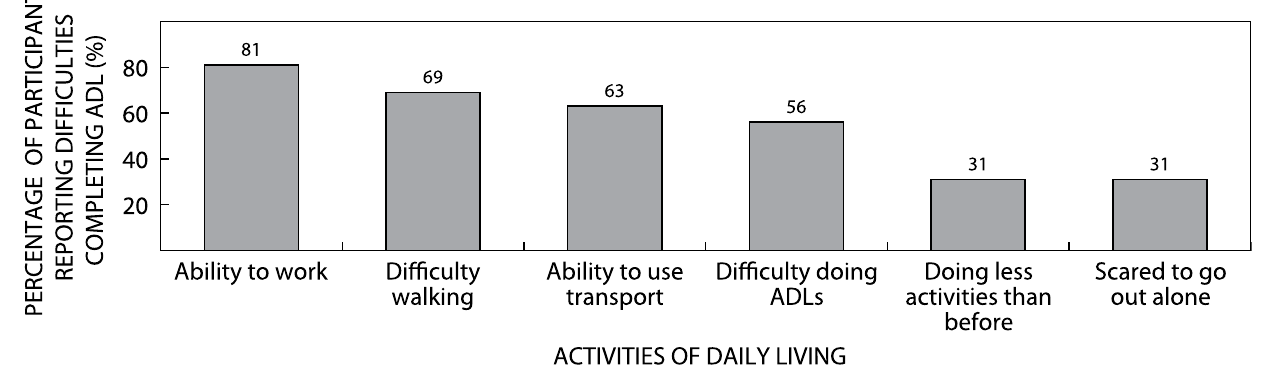
Figure 5: The effect that the pathological vestibular symptoms had on the participants’ activity and participation in everyday life ( N =